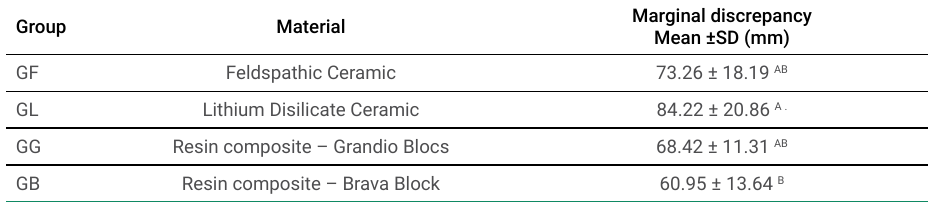
Table 2. Means and standard deviation (SD) of marginal discrepancy (values in micrometer - μm) within each of four groups tested